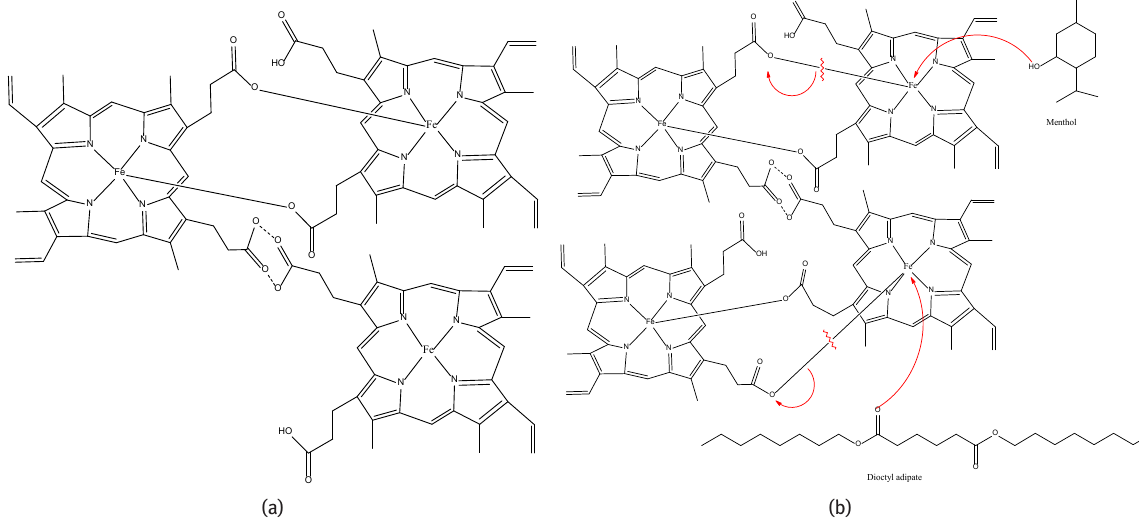
Figure 7 : The polymeration of β-hematin (a) and interaction of β-hematin polymer with menthol and dioctyl adipate